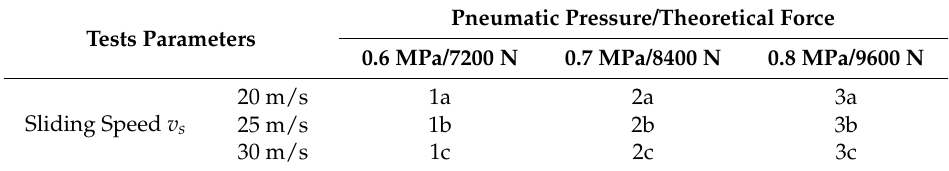
Table 2. Pin-on-disk test parameters.